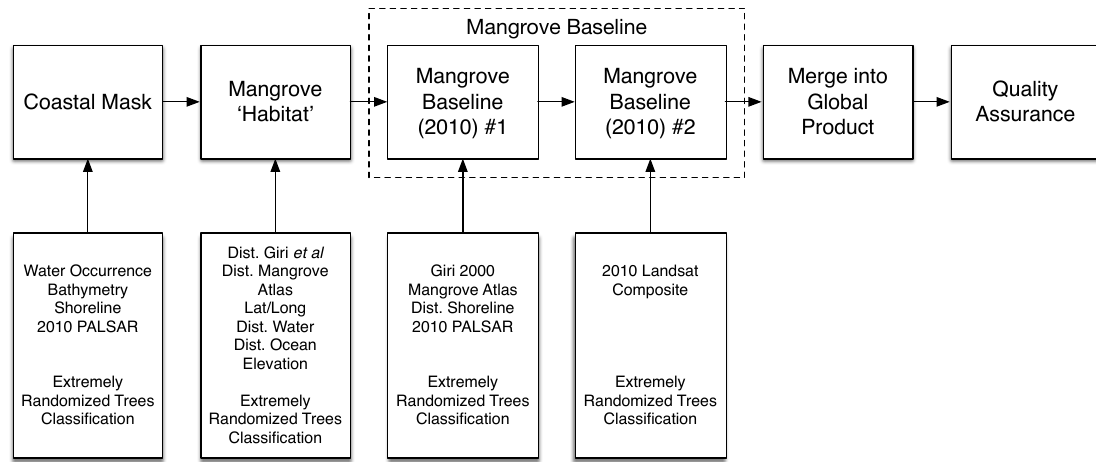
Figure 1. Overview of the methodology for producing a global mangrove baseline. The numbers reference the section number within the article, while the main flow of boxes indicate data dependency between the stages (e.g., the coastal water mask is used to defined the mangrove habitat mask). Table 1. Details of the datasets and sources used for this project.